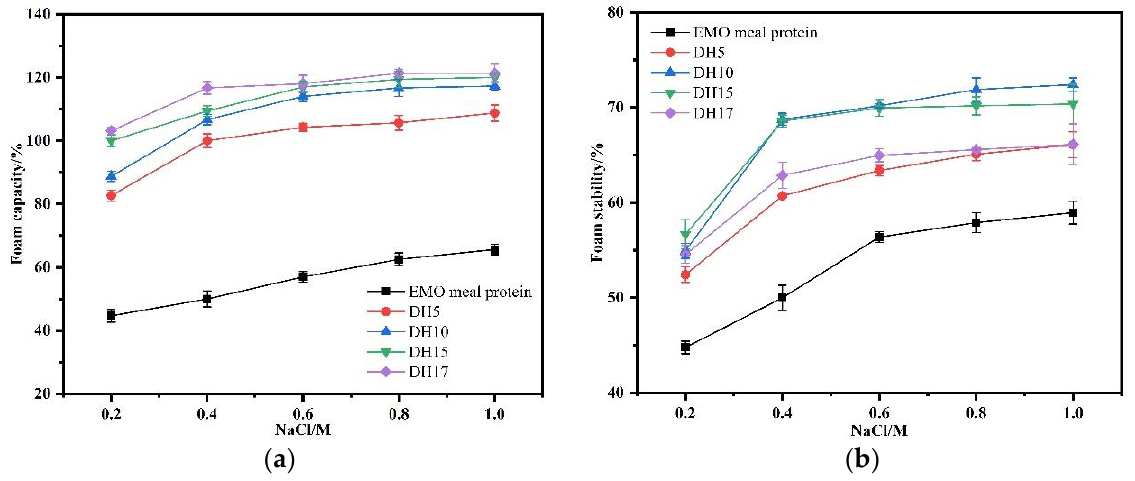
Figure 9. Effect of NaCl concentration on foam capacity ( a ) and foam stability ( b ) of the EMO meal protein and hydrolysates with different DH.